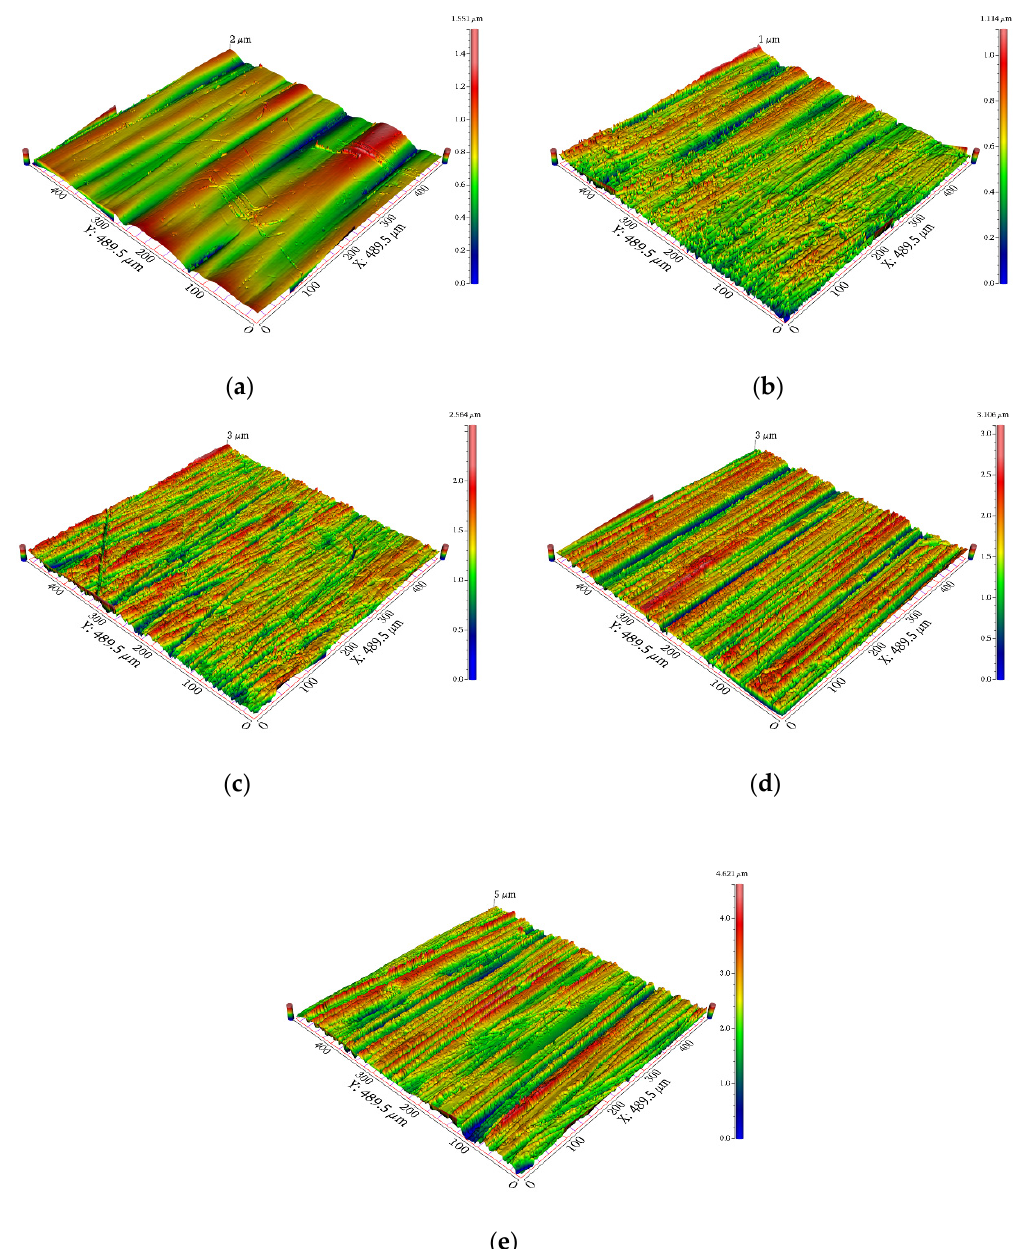
Figure 5. The topography of each cavity surfaces: ( a ) R 1 , ( b ) R 2 , ( c ) R 3 , ( d ) R 4 and ( e ) R